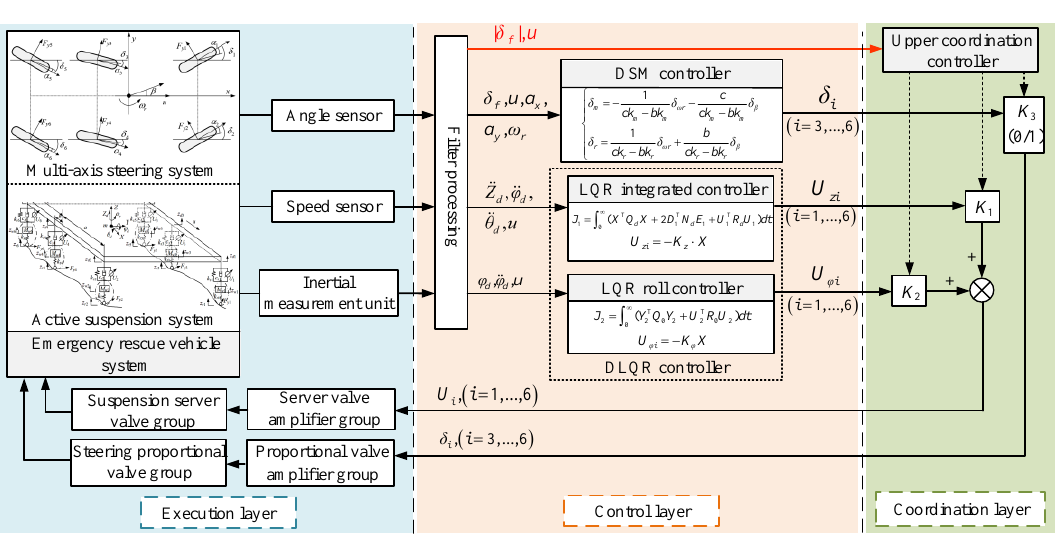
Figure 3. Coordination control strategy.